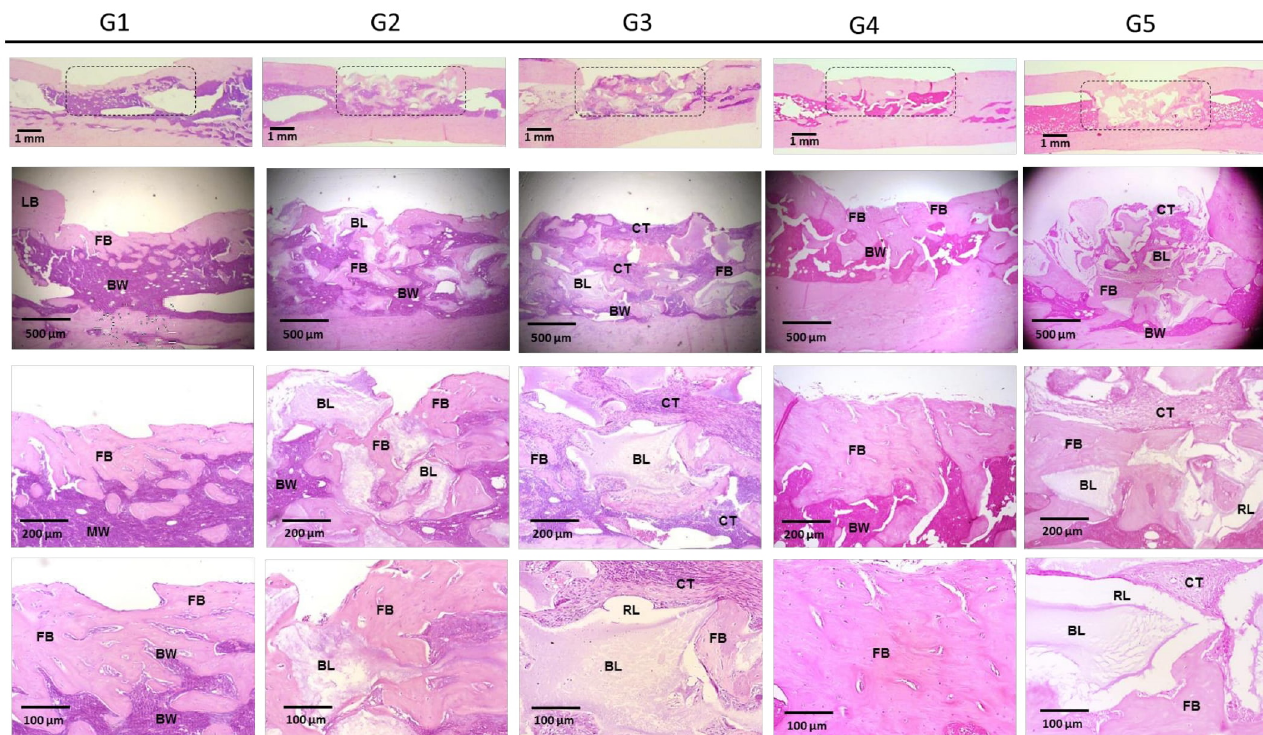
Figure 10. Representative images of histological sections stained with hematoxylin and eosin from the region of interest at 30 days after surgical procedure. LB: adjacent lamellar bone; FB: newly formed bone; BL: calcium phosphate biomaterial; RL: resorption lacunae; BW: bone marrow; CT: cellularized connective tissue.